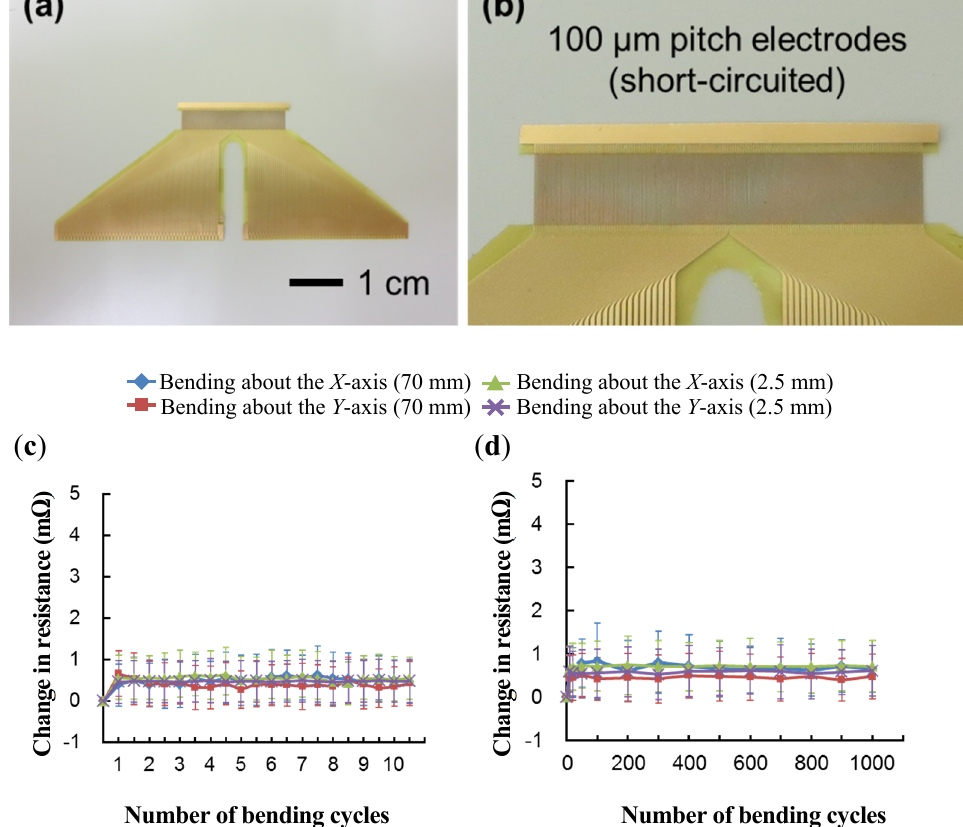
Figure 10. Investigation of the change in wiring resistance: ( a , b ) appearance of the electrically shorted film-type connector; ( c ) continuous measurements; and ( d ) intermittent